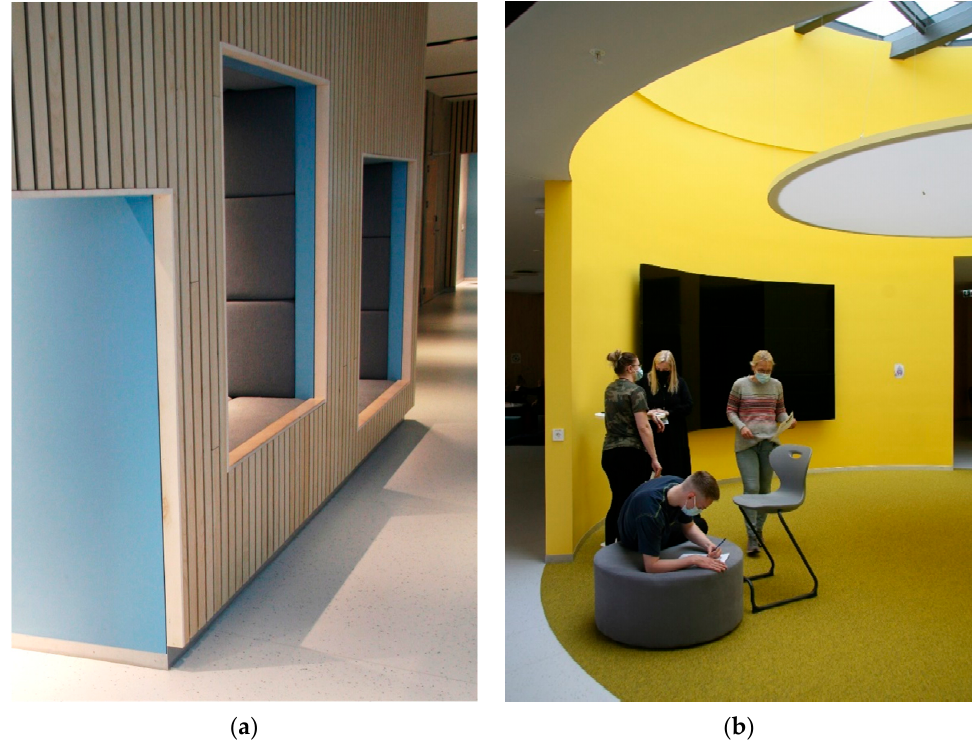
Figure 6. Focus groups and sheltered spaces . ( a ) Compartments and open areas in hallways were celebrated as optional settings for learning. ( b ) Oval cores in classrooms were also commended.